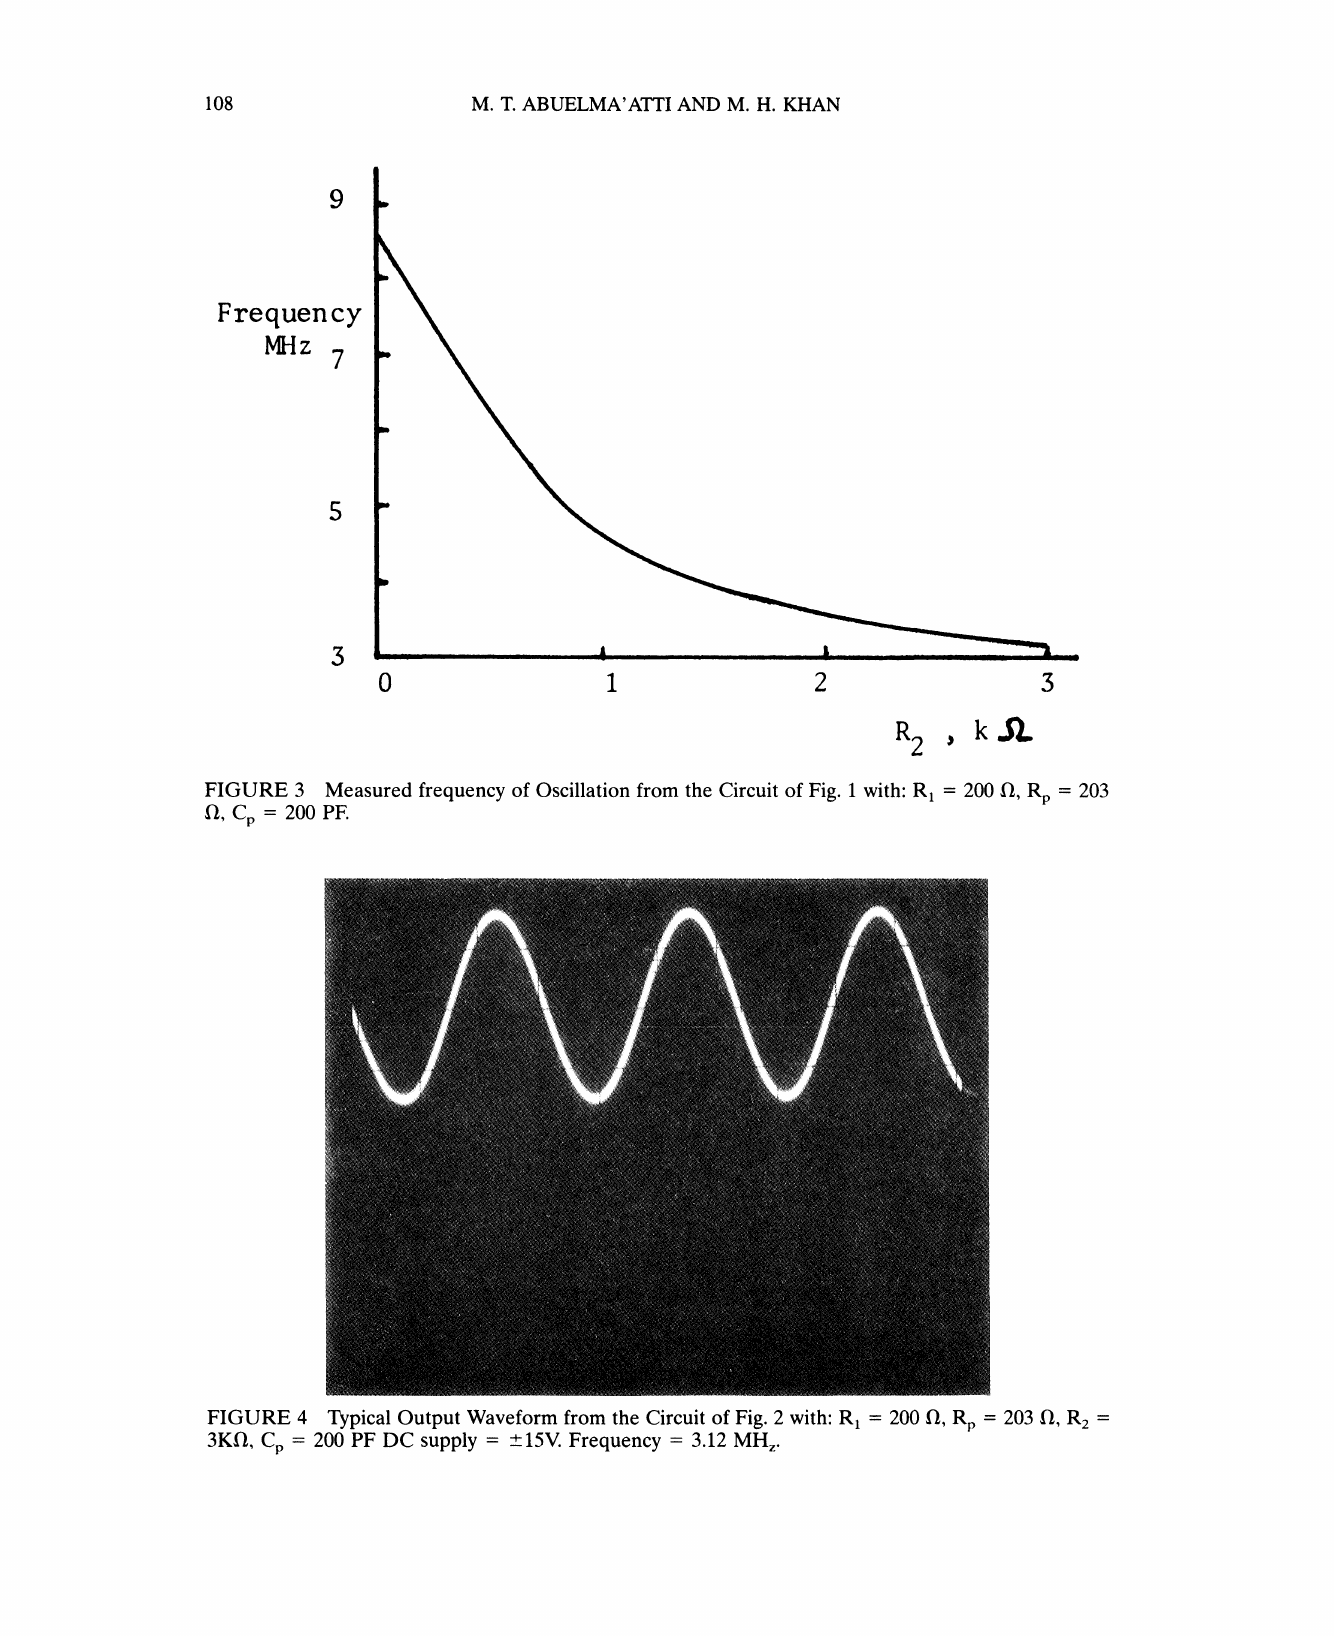
FIGURE 4 Typical Output Waveform from the Circuit of Fig. 2 with: